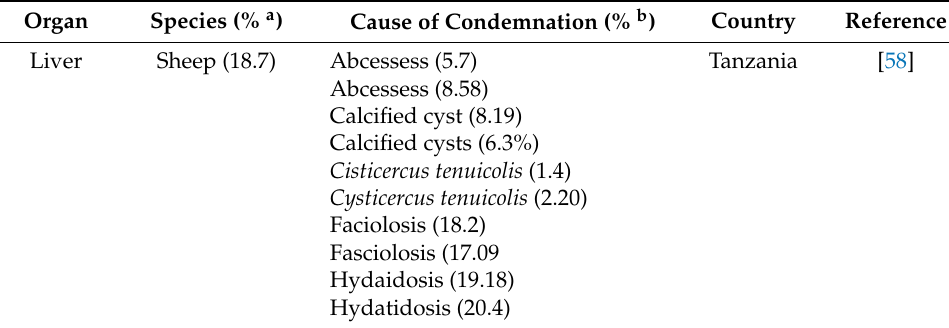
Table 5. Cause of organs condemnation in small